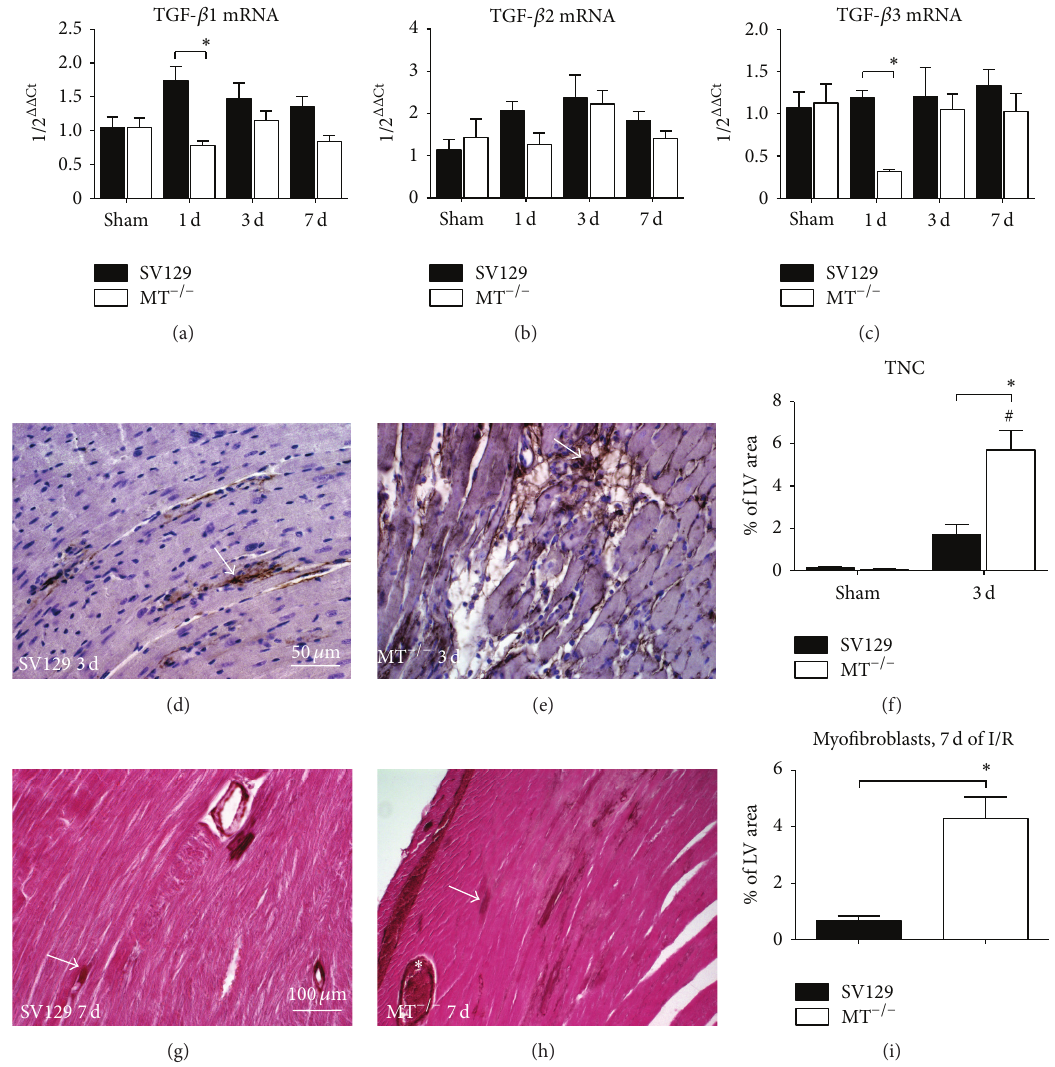
Figure 6: Adverse myocardial remodeling in MT −/− -mice. Gene expression of remodeling-related transforming growth factor 𝛽 isoforms (a) TGF- 𝛽 1, (b) - 𝛽 2, and (c) - 𝛽 3. Representative tenascin C (TNC) staining of WT- ((d), arrow) and MT −/− -hearts ((e), arrow) after 3 days of (d) I / R as well as the corresponding planimetric analysis (f). Representative left ventricular sections stained for myofibroblast marker 𝛼 -smooth muscle actin ( 𝛼 -SMAC) after 7 days of I / R show (g) only few interstitial myofibroblasts in WT-hearts (arrow) but (h) strong myofibroblasts staining predominantly in microinfarctions (arrow) of MT −/− -hearts after 7days of I / R. (i) Planimetric analysis of 𝛼 -SMAC + in both genotypes. 𝑛 = 8–10/group; scale bars in (d) and (e): 50 𝜇 m, in (g) and (h): 100 𝜇 m; RT-qPCR using Taqman; mRNA expression is related to shams and GAPDH using comparative ΔΔ Ct-method; ∗ indicates P ≤ 0.05 between the genotypes; # indicates P ≤ 0.05 versus respective